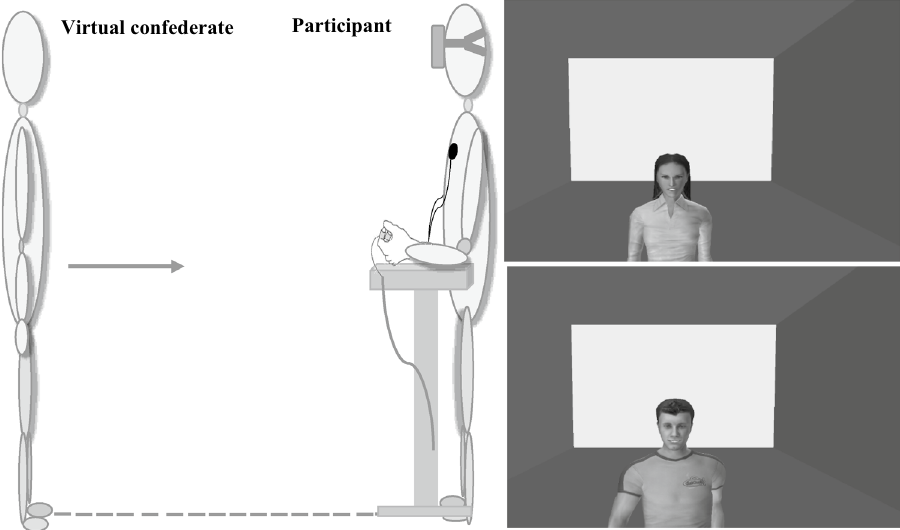
Figure 5. Example of experimental procedure and virtual stimuli. On the left , the panel shows a virtual confederate frontally approaching a participant. Participants, who were wearing HMD and psychophysiological devices, were told to stop virtual confederates when they thought they could reach them (Reaching-distance) or felt comfortable with their proximity (Comfort-distance). During the task, SCR, IBI and spatial distance were recorded. The small table was used to support participants’ forearm and non-dominant hand. The small table was on the left side of the participant. On the participant’s chest were three ECG sensors for IBI acquisition; on the non-dominant hand were the electrodes for the SC acquisition. On the right , the panel shows examples of angry ( top ) and happy ( bottom ) facial expressions of female and male virtual